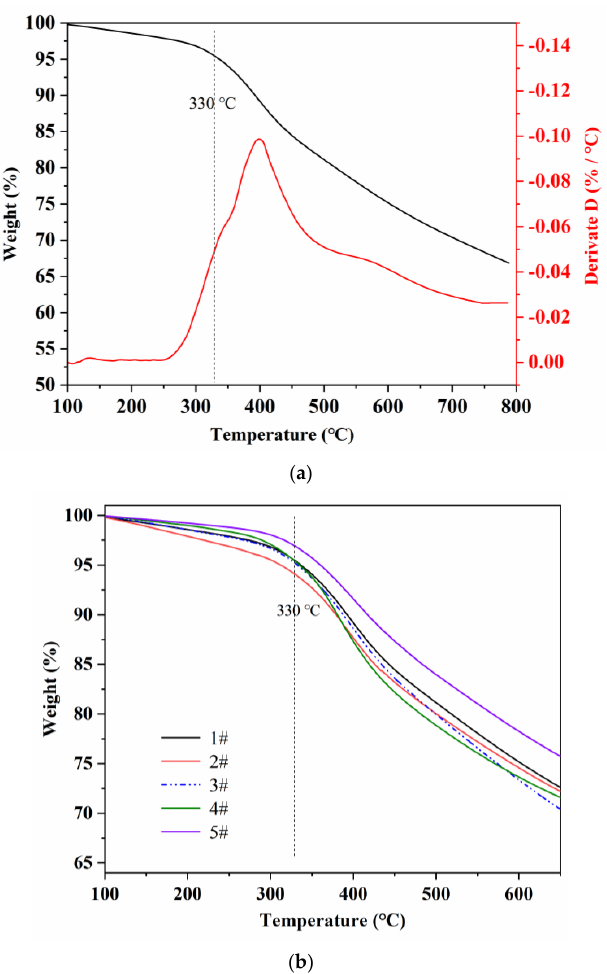
Figure 10. Thermogravimetric curve of 1# to 5# samples ( a ) TGA/DTGA curve of 1# pre-oxidized fiber ( b ) TGA curve of 1# to 5#